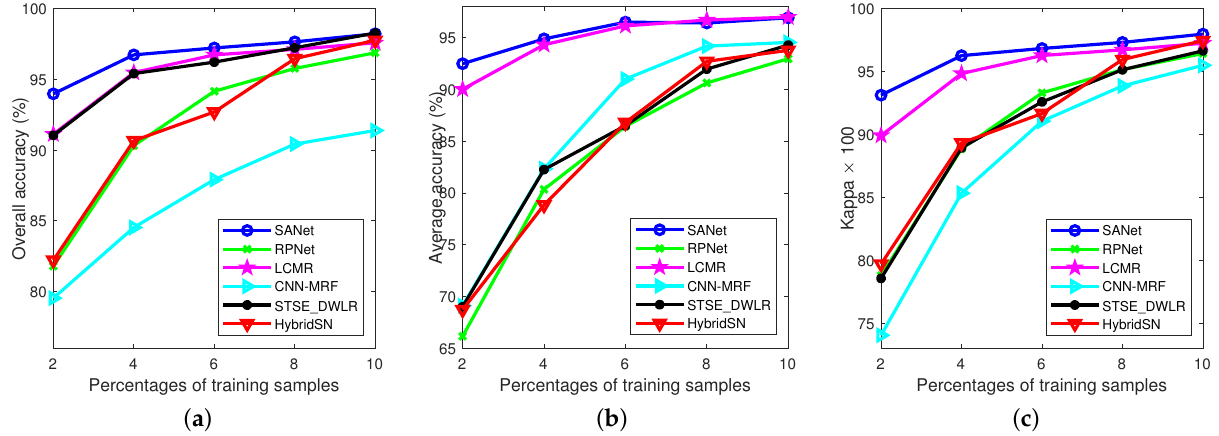
Figure 11. Experimental results of different methods with various numbers of training samples on Indian Pines data set. ( a ) OAs; ( b ) AAs; ( c ) κ